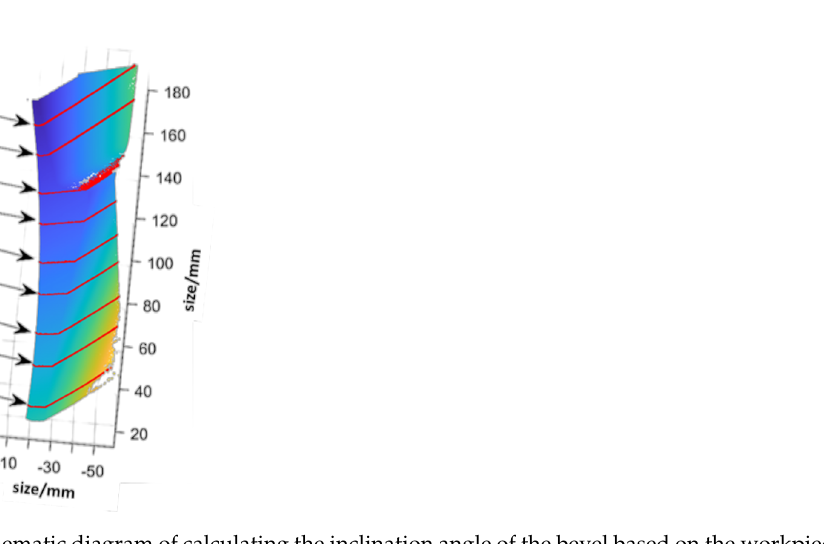
Figure 21. Schematic diagram of calculating the inclination angle of the bevel based on the workpiece point cloud after